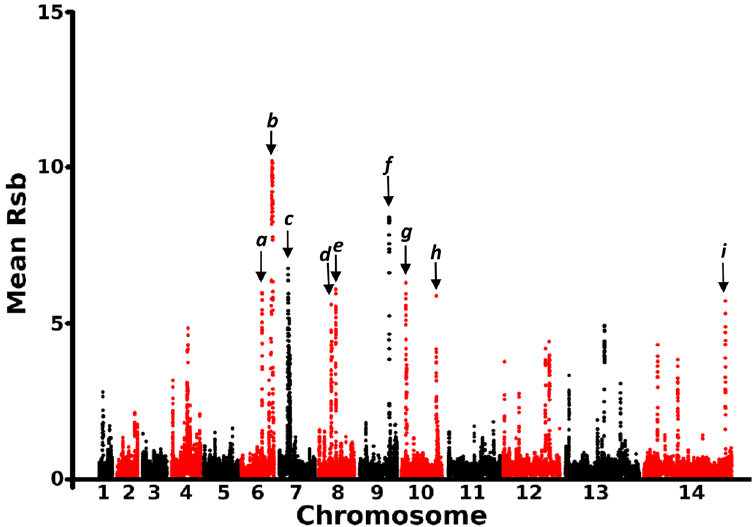
Figure 3. Mean Rsb index scores of SNPs across the P. falciparum genome over all pairwise comparisons of 11 local populations in West Africa. This index of the relative rate of breakdown of haplotype homozygosity is used here to identify loci with the most substantial differences in extended haplotypes among the populations, as this may indicate local differences in recent selection. All population pairwise Rsb values were determined for 35,228 SNPs, and the mean score for all pairwise comparisons was calculated from the absolute score magnitudes (Supplementary Datafile S2). The top nine genomic windows each had at least three SNPS with a mean Rsb > 3 and at least one SNP with a mean Rsb > 5: ( a ) chromosome (chr) 6